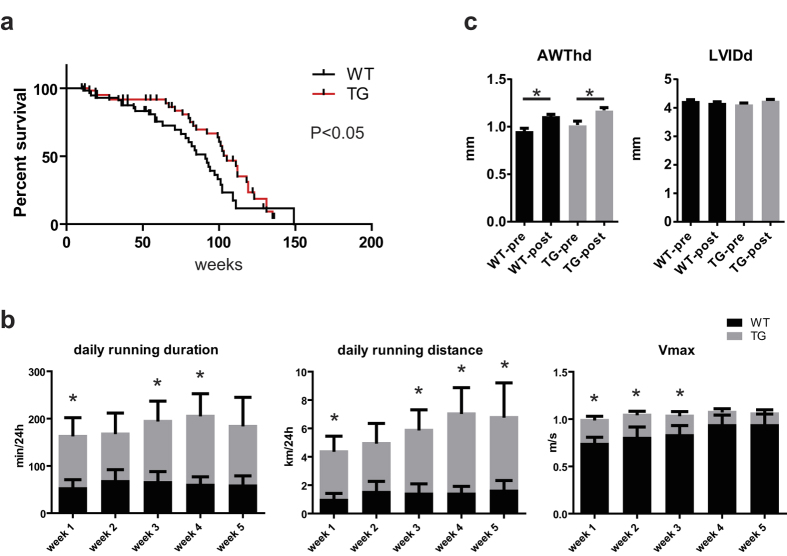
Longevity and exercise endurance in TBC1D10C TG mice.(a) Kaplan–Meier analysis of survival was determined in a prospectively defined cohort of mice. Spontaneous deaths were recorded (WT: n = 79; TG: n = 86; P < 0.05; log-rank (Mantel–Cox) test). (b) Voluntary running was recorded over 5 weeks. TG mice exhibited significantly longer daily running duration at weeks 1, 3 and 4, longer running distance at weeks 1, 3, 4 and 5, and Vmax was significantly increased at weeks 1, 2 and 3 (WT: n = 6; TG: n = 8; P < 0.05). (c) Exercise-induced hypertrophy of the anterior wall (anterior wall thickness in diastole (AWthd)) was similar between WT and TG mice. Left ventricular enddiastolic diameter (LVIDD) remained unchanged.